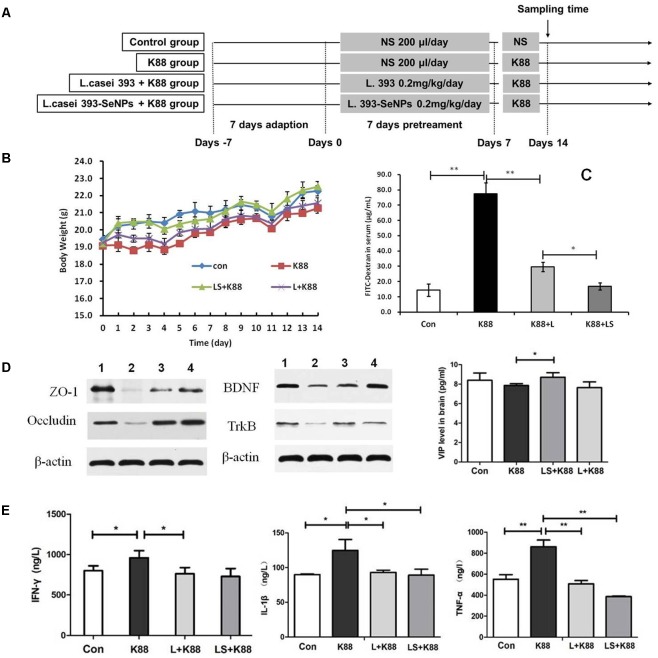
Protective effect of L. casei 393-SeNPs on the C57BL/6 mice challenged by ETEC K88. (A) The scheme of experiment in vivo. (B) The change of weight during the whole experiment. (C) Modulatory effect of L. casei 393-SeNPs on the C57BL/6 mice challenged by ETEC K88. FITC-dextran was used as the indicative material. (D) The expression levels of tight junction proteins (ZO-1 and occludin) in ileum, and BDNF and TrkB in brain from the different experiment rats. 1, Control; 2, K88; 3, L+K88; and 4, LS+K88. (E) The serum levels of IFN-γ, IL-1β, and TNF-α, and the level of VIP in brain determined by ELISA. All data were presented as mean ± SEM (n = 8), ∗P < 0.05, ∗∗P < 0.01. K88 means the rats orally administrated with ETEC K88 only. LS + K88 means the rats pretreated with L. casei 393-SeNPs before administration with ETEC K88. L + K88 means the rats pretreated with L. casei 393 before administration with ETEC K88. ZO-1, zonula occludens 1; BDNF, brain-derived neuotrophic factor; TrkB, tropomyosin receptor kinase B.